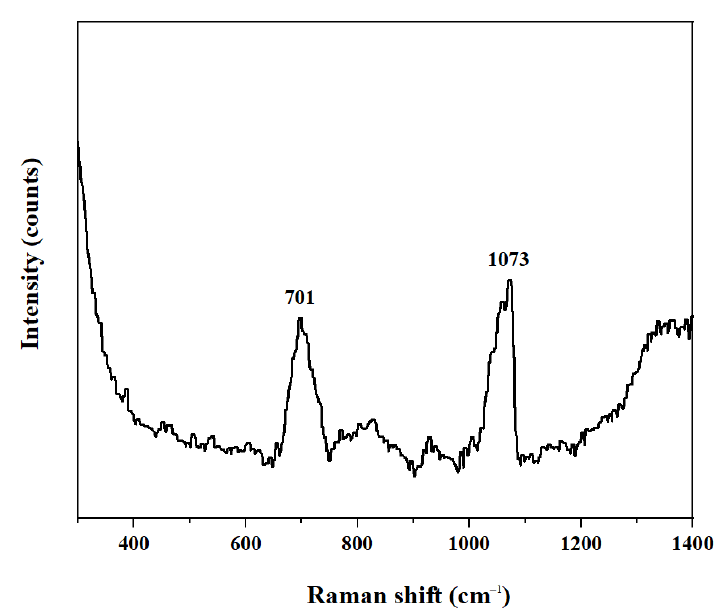
Figure 2. Raman spectrum of Ag 2 CO 3 .